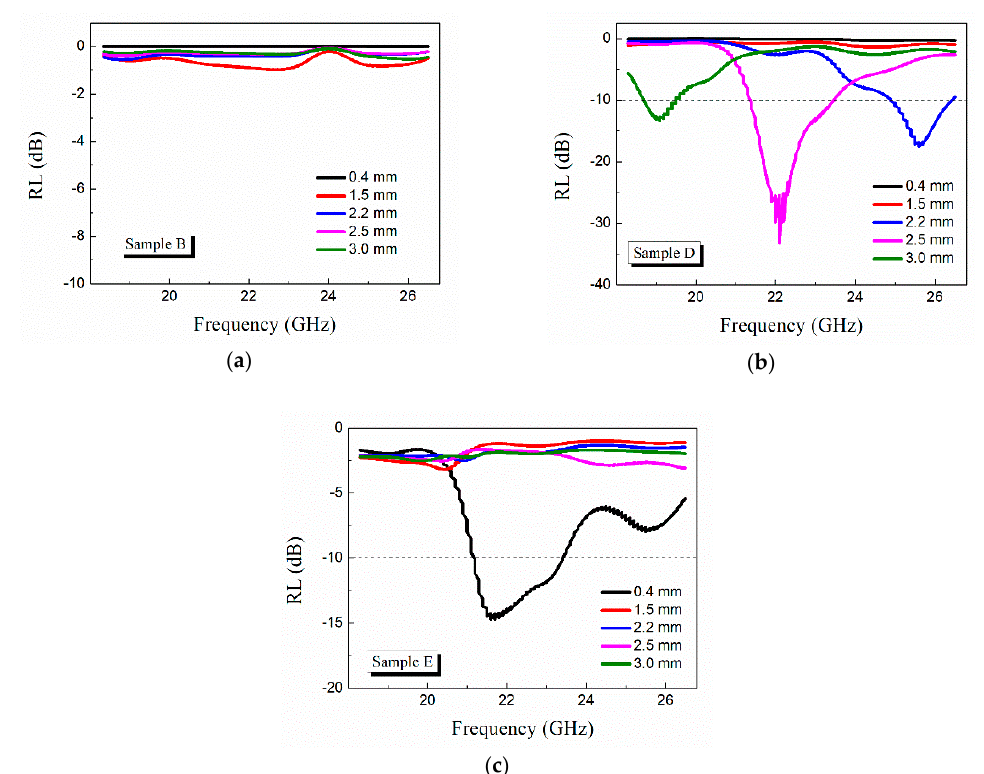
Figure 8. Frequency dependency of the reflection loss (RL) of samples B ( a ), D ( b ), and E ( c ) with different thickness in K-band.